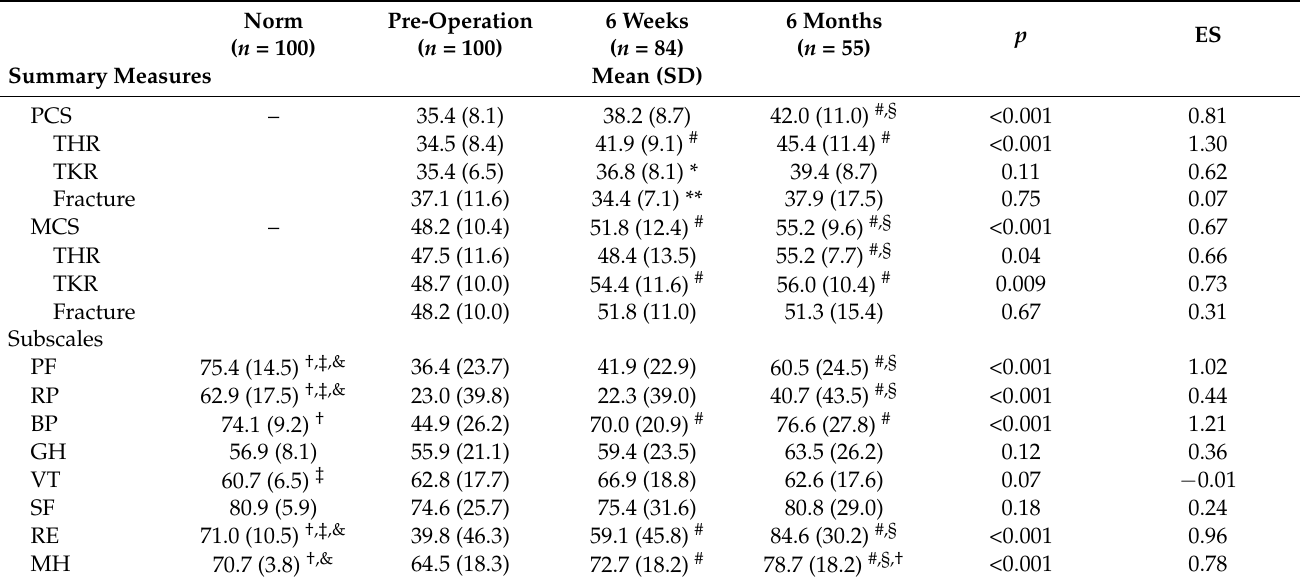
Table 2. The SF-36 summary measures and subscales at pre-operation, and 6-week and 6-month follow-up of the age-/sex-matched normative values and